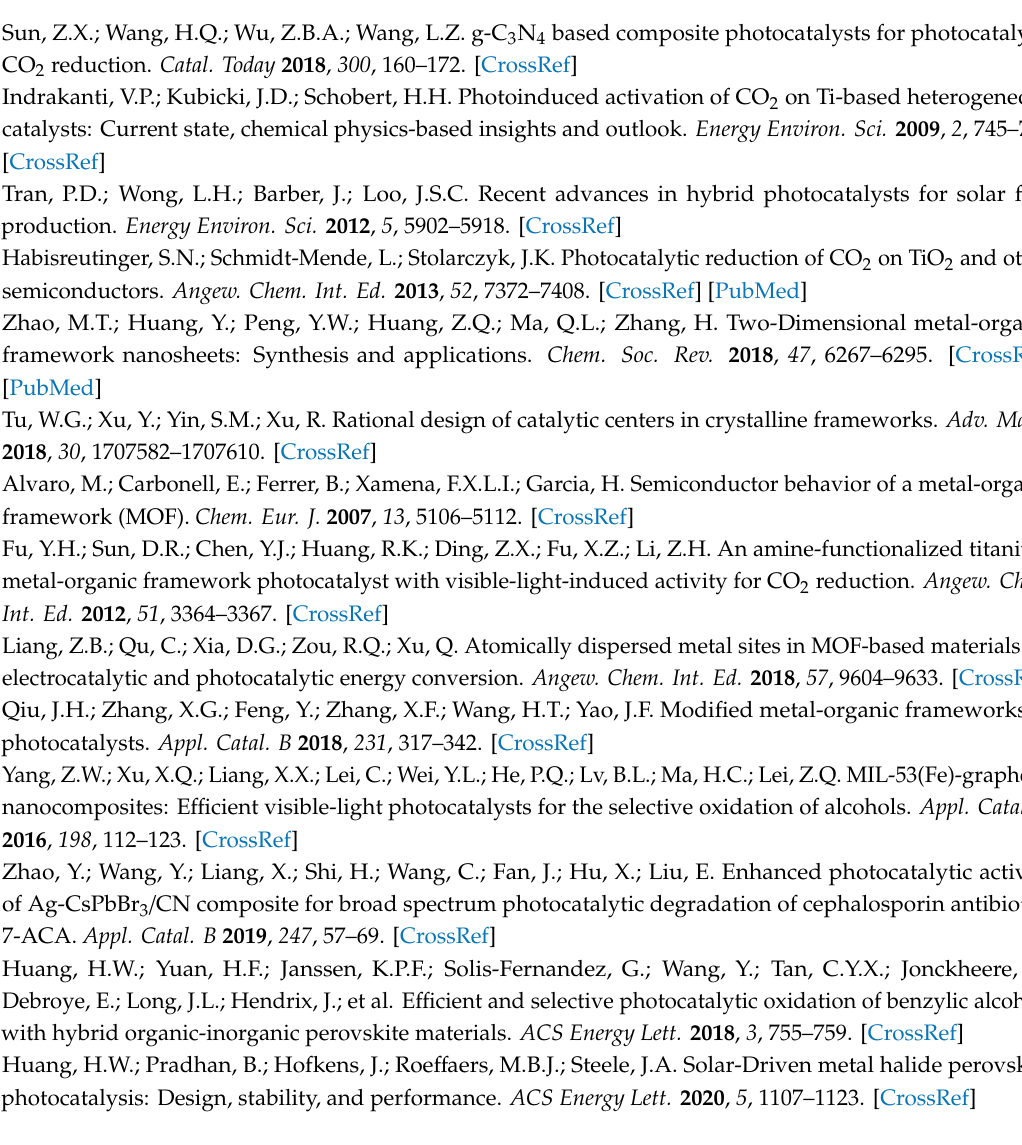
Figure S1: XPS spectra of p-90Fe, Figure S2: Photoluminescence spectra of the as-prepared samples at an excitation wavelength of 380 nm, Figure S3: Typical SEM images of CsPbBr 3 , MIL-100(Fe) and p-90Fe, and EDS pattern of the selected region in p-90Fe, Figure S4: XRD pattern of p-90Fe before and after a 16 h photocatalytic reaction, Figure S5: N 2 adsorption-desorption isotherms and CO 2 adsorption isotherms of the photocatalysts, Figure S6: N 2 adsorption-desorption isotherms and pore size distribution curves of the p-90Fe before and after reaction, Figure S7: Valence band XPS spectra of MIL-100(Fe), CsPbBr 3 and p-90Fe, Table S1: Summary of the reported photocatalytic CO 2 reduction performance of perovskite-based and traditional photocatalysts under various illumination